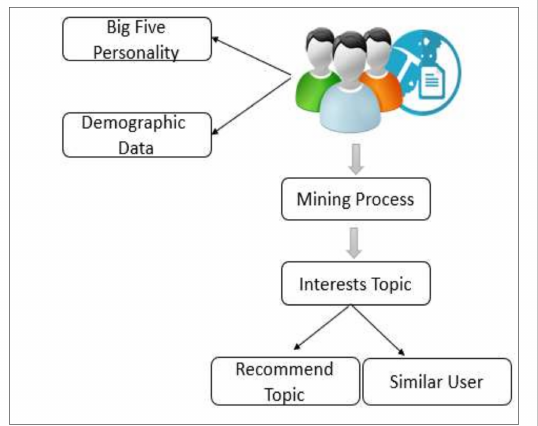
Figure 1. General System Architecture for Mining User Interest from Social